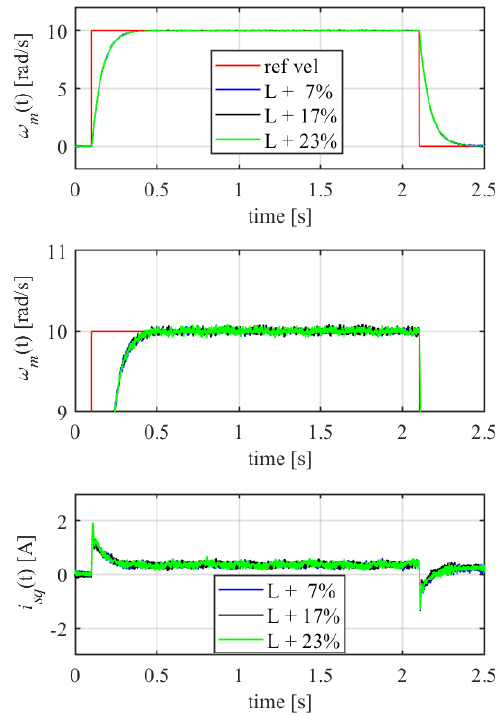
Figure 14. SFC step response for inductance and resistance variations under no-load